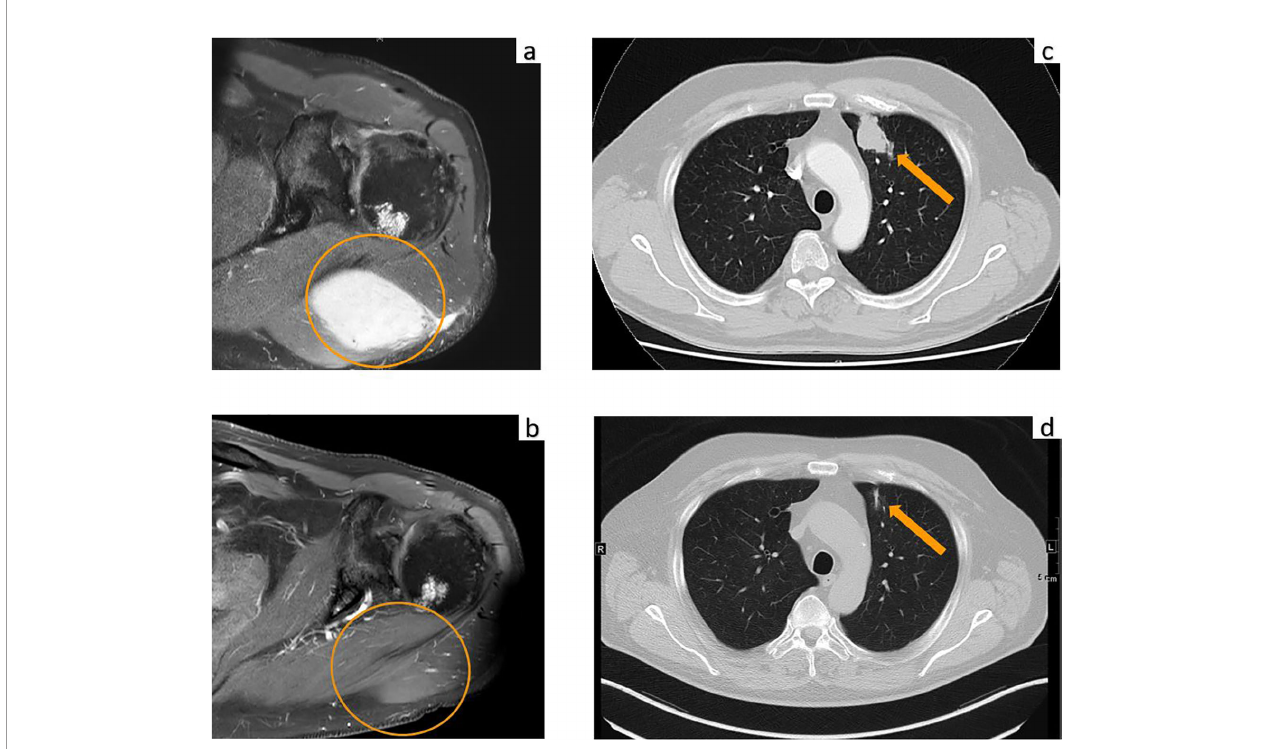
FIGURE 1 | MRI of the upper left extremity: (A) Strong contrast enhancement of a 4.0 × 2.6 cm metastasis of the left deltoid muscle before initiation of immunotherapy. (B) Complete resolution of the tumor mass at three months after the fi rst and only dose of ipilimumab plus nivolumab. Computed tomography of the chest: (C) Metastasis of the left upper lobe (arrow) before initiation of immunotherapy. (D) Complete resolution of the lung metastasis with residual dystelectasis (arrow) at three months after the fi rst and only dose of ipilimumab plus